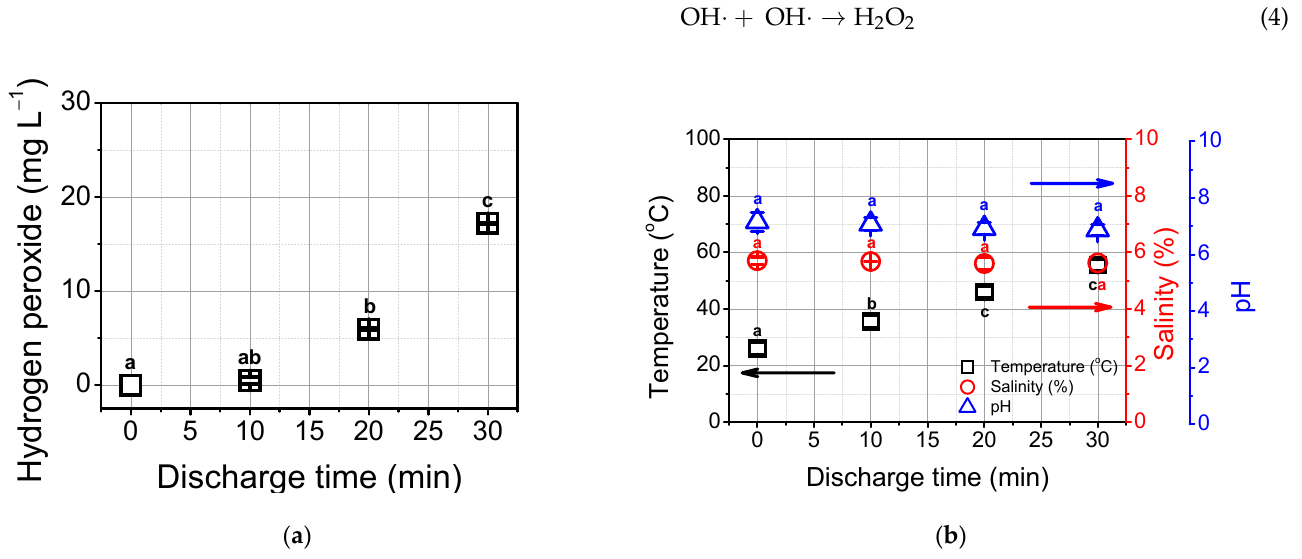
Figure 2. The characteristics of underwater plasma in saline water. ( a ) Voltage and current signals; ( b ) optical emission spectrum (OES) signals.